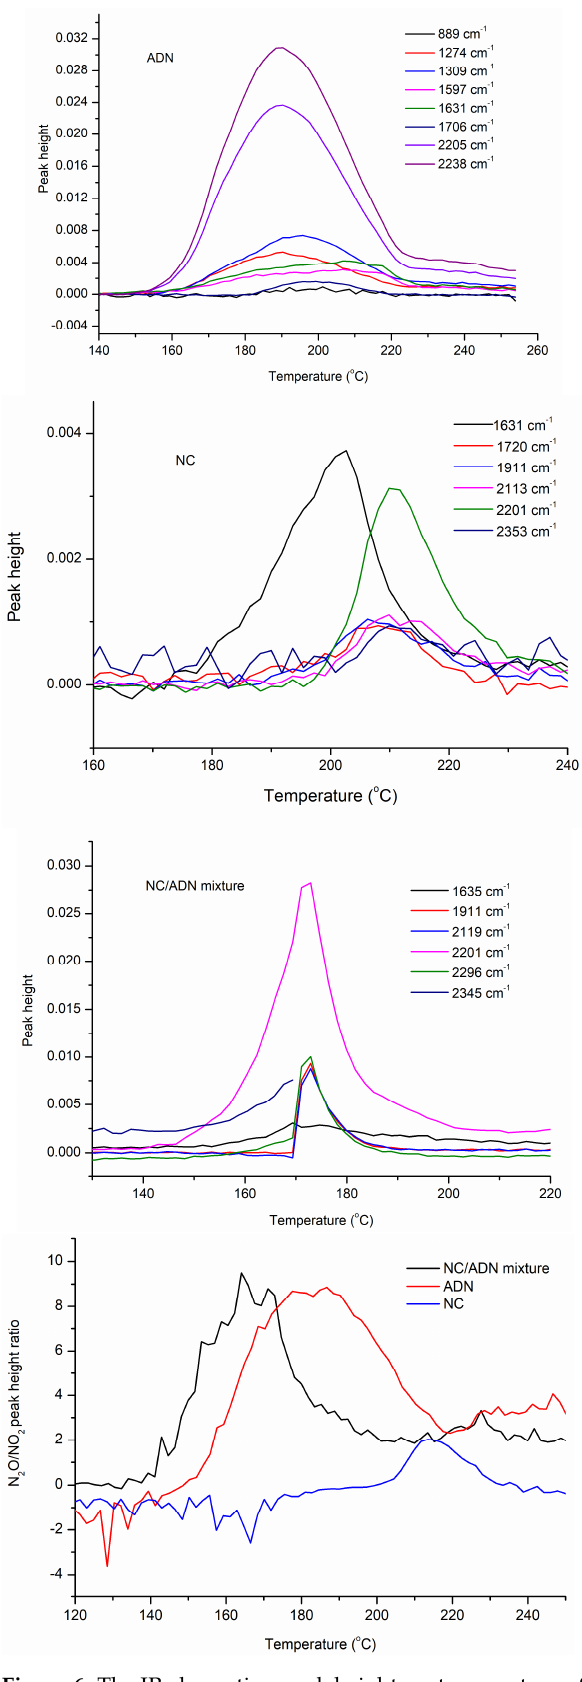
Figure 6. The IR absorption peak height vs. temperature of the main gas products of ADN, NC and NC/ADN mixture. It can be seen that the main IR-active thermal decomposition products of ADN in- cluded NH 3 , N 2 O and NO 2 , wherein the N 2 O intensity was the highest. It was found that NO 2 formed firstly at 141.1 °C (1631 cm − 1 ) through the break of the N-NO 2 bond, then N 2 O began to form at 144.8 °C (1274 cm − 1 ) by the combination of the central nitrogen atom and the nitrogen on the NO 2 group through ADN anion rearrangement [26]. Until the temperature reached 177.6 °C, NH 3 (889 cm − 1 ) appeared. As NH 3 can become volatile quickly once formed, we speculate that ADN decomposed in the form of ion NH 4+ N(NO 2 ) 2 − without proton transfer from the cation to anion to form H + N(NO 2 ) 2 − (HDN) and NH 3 from 141.1 °C to 177.6 °C after the ADN melted. Due to the ADN mol- ecule not containing the carbon element, the appearance of CO 2 (2343 cm − 1 ) at 142.1 °C can be ascribed to the oxidation of the processing aid, which was introduced to assist ADN crystallization. The same as described in the literature [16,17,32], the main thermal decomposition gas products of NC comprised NO 2 , N 2 O, NO, CO, CO 2 and aldehyde (CH 2 O) or car- boxylic acid (HCOOH), wherein the intensity of NO 2 and N 2 O were the highest. NC started to decompose with the dissociation of the O-NO 2 bond and formed NO 2 gas, which was detected via the IR detector at 166.5 °C (1631 cm − 1 ). The carbon–oxygen skel- eton of the cellulose was oxidized by NO 2 to form aldehyde or carboxylic acid, which can be found at 184.6 °C (1720 cm − 1 ) followed by the formation of NO at 186.4 °C (1911 cm − 1 ) and CO at 189.9 °C (2113 cm − 1 ). Further reaction of the formed intermediate products produced the N 2 O at 195.4 °C (2201 cm − 1 ), CO 2 at 200.8 °C (2353 cm − 1 ) and HCN at 202.7 °C (714 cm − 1 ). Furthermore, the main IR-active gases of the NC/ADN mixture included N 2 O, NO 2 , NO, CO and CO 2 . The absorbance (1390 cm − 1 ) appearing at 13.904 min can probably be ascribed to the formation of HNO 2 or HNO 3 . However, the signal of NH 3 released from ADN and aldehyde or carboxylic acid produced by NC thermal decomposition became too weak to be detected. It can be speculated from the IR result that the MS fragment 17 denoted OH, not NH 3 gas; similarly, fragment 30 denoted NO, not CH 2 O gas. The dis- appearance of NH 3 in the IR spectroscopy of the NC/ADN mixture was assumed to be because the NH 3 was oxidized by NO 2 to form N 2 and H 2 O. Similarly, the aldehyde dis- appearance may be due to the aldehyde being oxidized by NO 2 or O 2 to form CO and CO 2 . As the NC/ADN mixture started to decompose, instead of NO 2 , N 2 O (1274 cm − 1 , 2201 cm − 1 ) began to form at 139.3 °C, which was 5.5 °C less than that of N 2 O formation in the decomposition process of ADN. On the contrary, NO 2 was detected for the NC/ADN mixture until the temperature reached 148.2 °C, which was 7 °C higher than that of NO 2